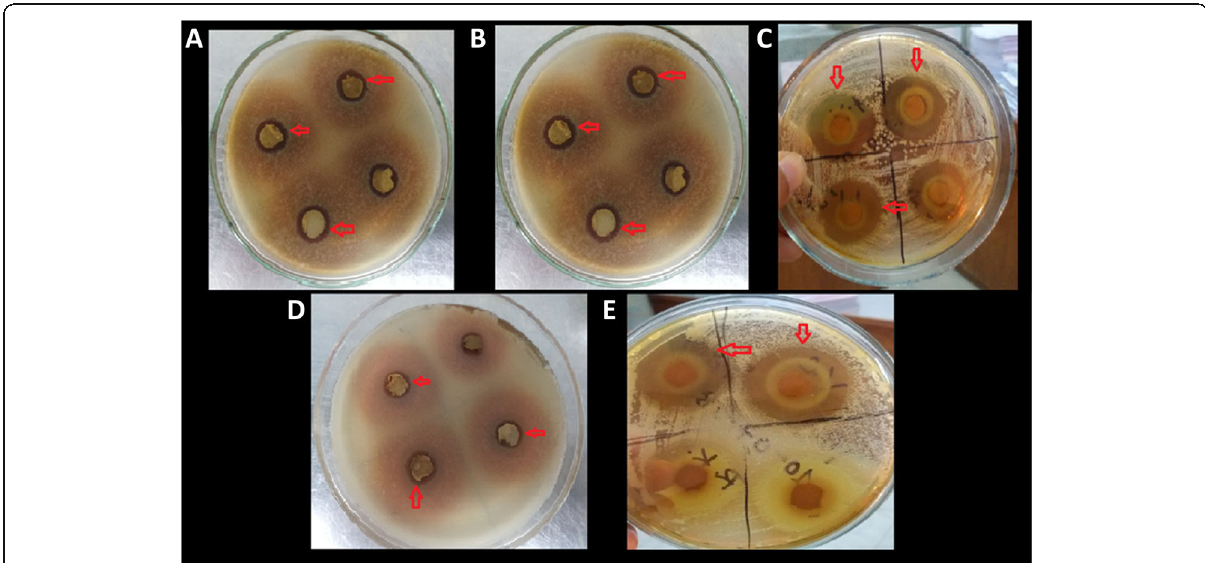
Fig. 1 Images of MIC (minimum inhibitory concentration) test. a , b & c were 2.5, 5, and 15 mg/ml of ethanolic extracts of Terminalia citrina (Roxb.) fruits. d & e were 5 and 15 mg/ml of methanolic extracts of Terminalia citrina (Roxb.) fruits. Each sample was replicated as n = 4. The zone of inhibition is indicated in the red